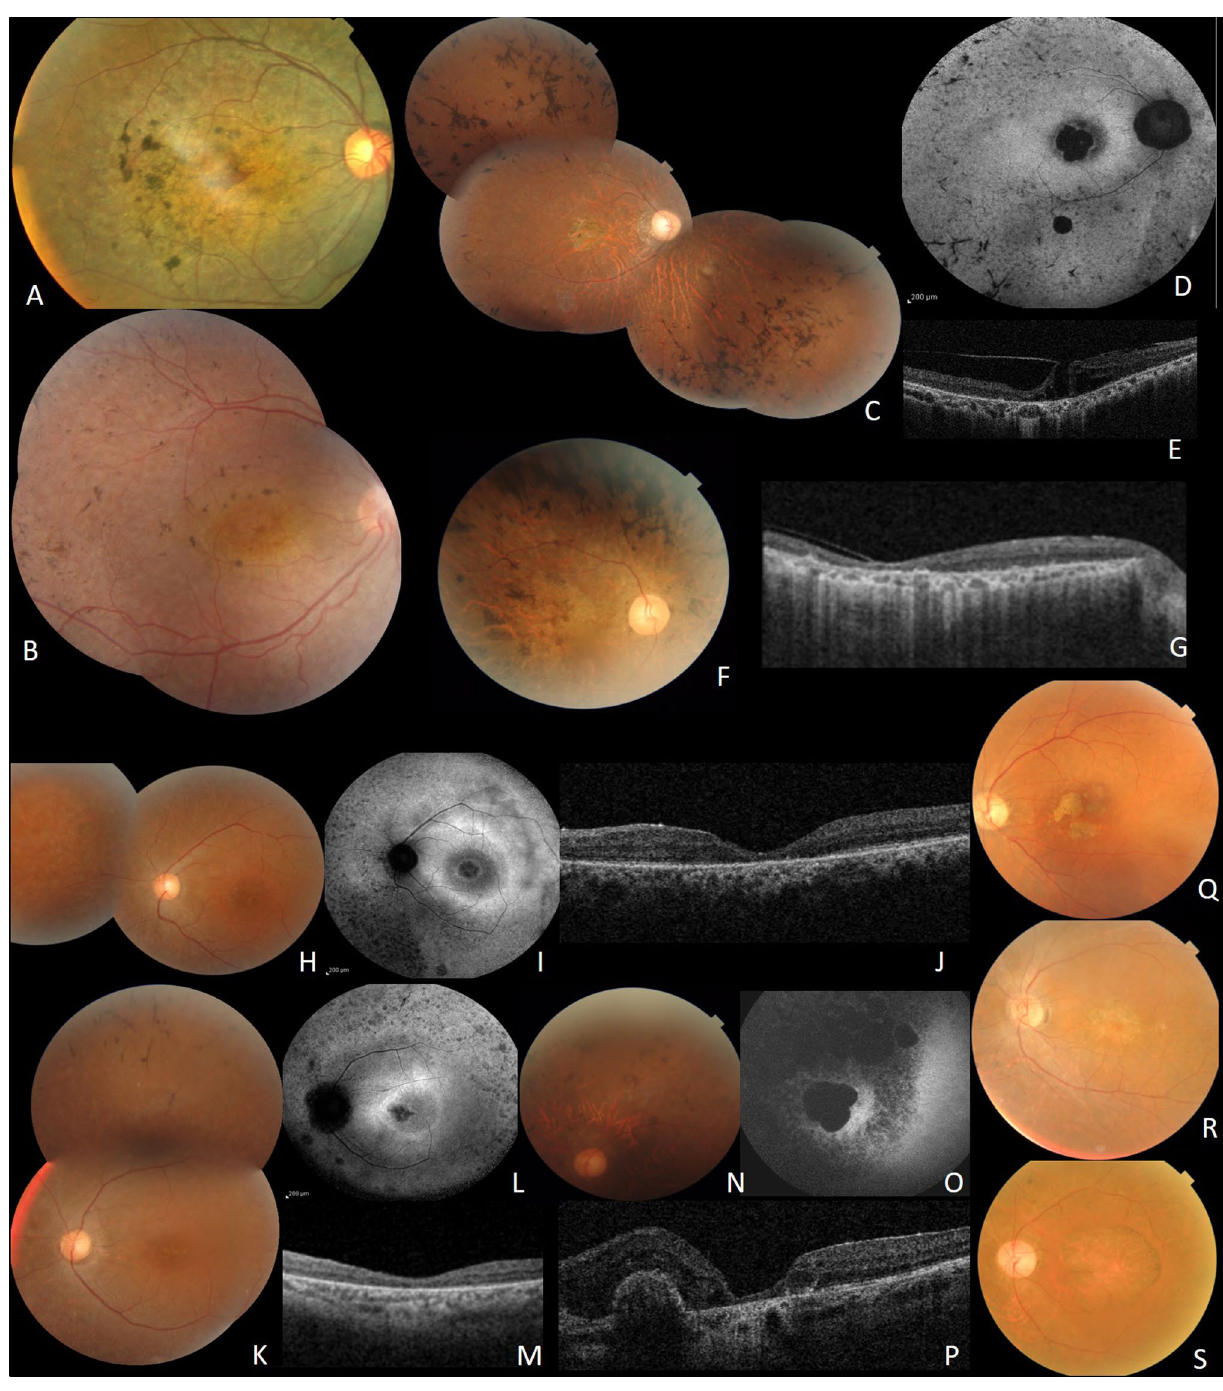
Figure 3. Clinical features of CRD patients; A F6, RE fundus of patient II.1. B F7, RE of patient II.1. C, D, E, F and G Clinical features of patients from F8. C: Fundus imaging of RE of index patient III.2. D FAF showing central macular hypoFAF surrounded by ring of hyper FAF, small areas of hypoFAF in the mid-periphery. E SS-OCT showing vitreo-retinal traction with macular hole. F fundus photo of the right eye of patient III.3. G SS-OCT showing diffuse chorio-retinal atrophy. H, I, J, K, L, M, N, O and P Clinical features of patients from F9. H Fundus imaging of LE of patient IV.4. I FAF showing central macular hypoFAF surrounded by ring of hyper FAF. J SS-OCT showing macular atrophy. K fundus photo of the left eye of the sister IV.6. L FAF showing central macular hypoFAF surrounded by ring of hyper FAF. M SS-OCT showing macular atrophy. N fundus photo of the left eye of IV.2. O FAF large macular atrophy surrounded smaller areas of atrophy. P SS-OCT showing macular atrophy with parafoveolar gliosis. Q, R and S Clinical features of patients from F9 showing cloverleaf maculopathy with peripheral RPE